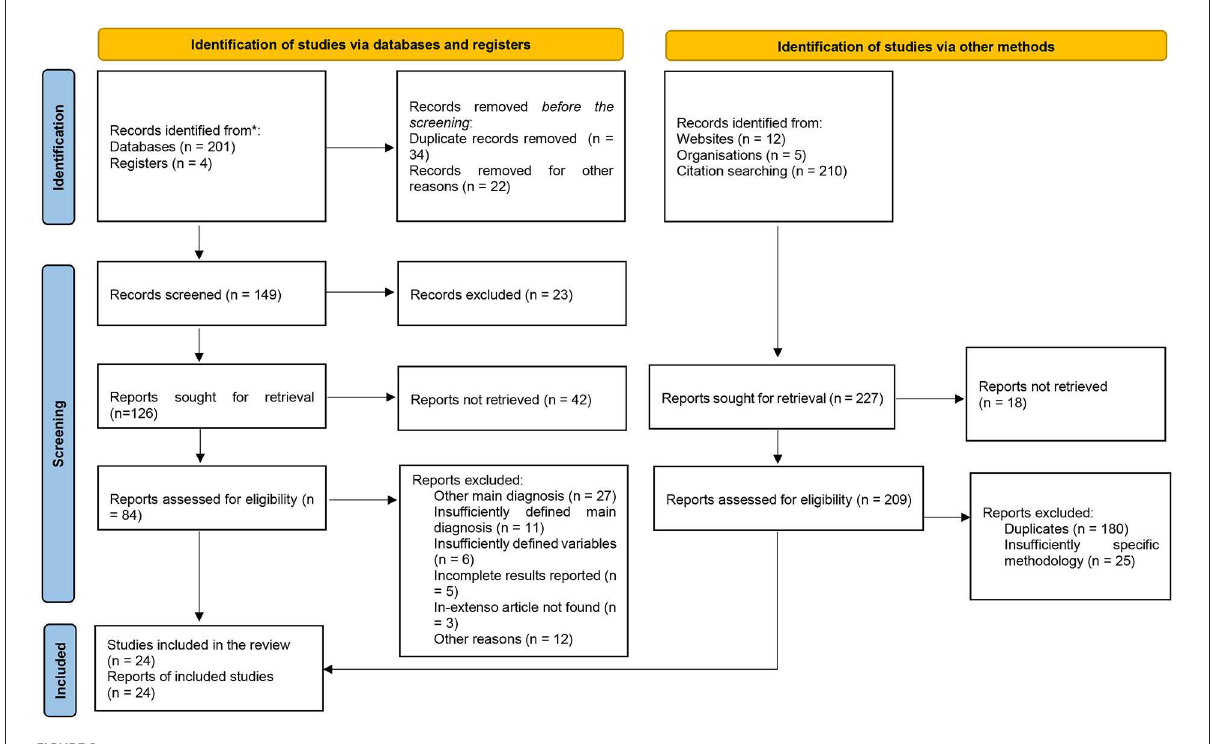
FIGURE2 PRISMA 2020 flow diagram for systematic reviews (31).